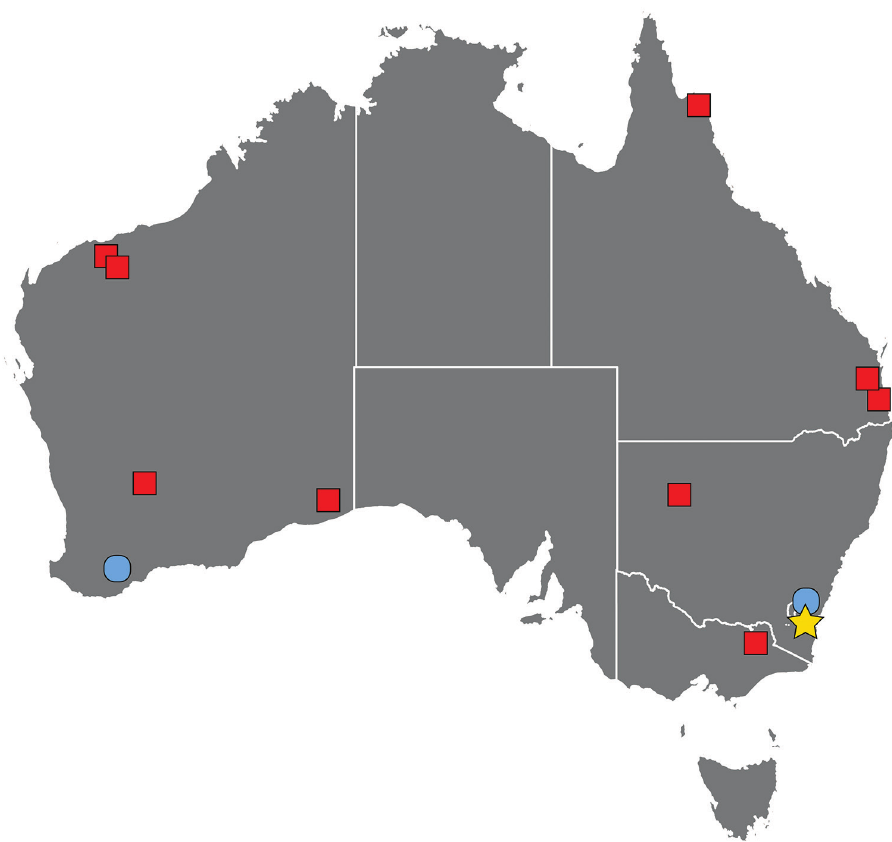
Figure 1. Known distributions of D. xenomorph (blue circles) D. finchi (red squares) and D. mediocaudata (yellow